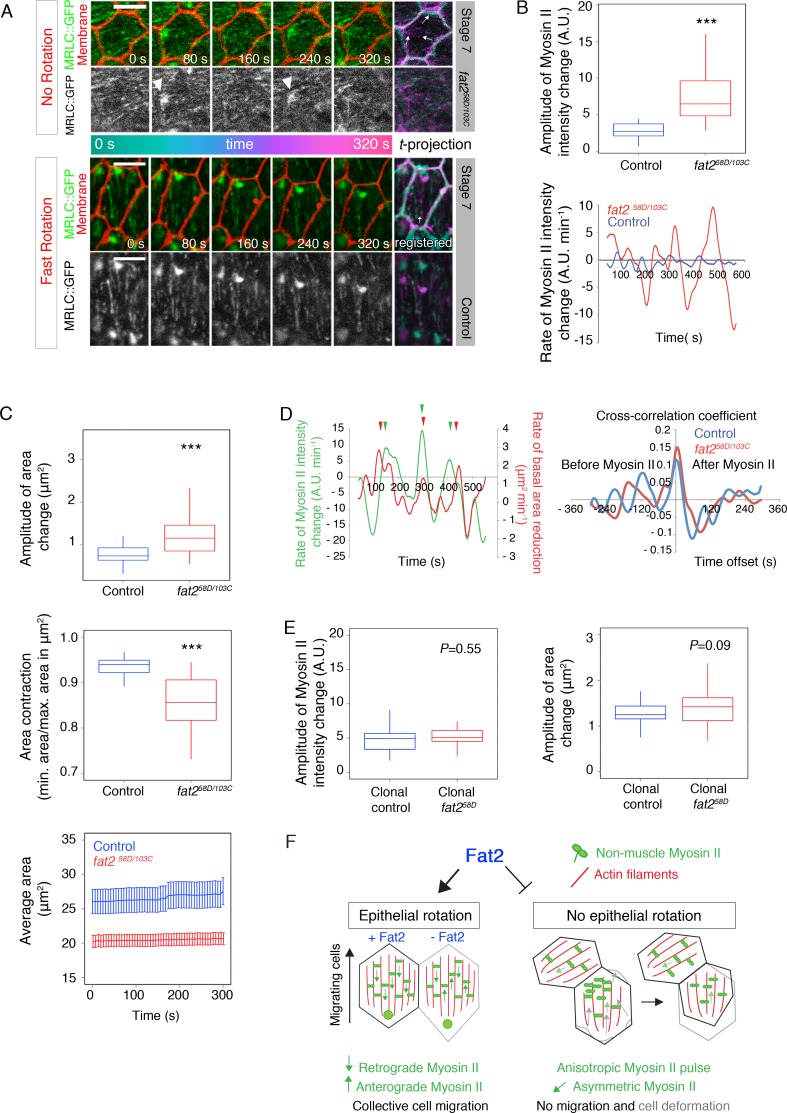
Epithelial rotation suppresses premature Myo-II anisotropic pulses and cell deformations.(A) Unequal MRLC::GFP intensity increments (Myo-II anisotropic pulse) and membrane deformations are shown in fat2 mutant follicle cells (stage 7). Arrowheads indicate an individual MRLC::GFP intensity increase (a pulse). Note that MRLC::GFP pulses were not observed in control stage 7 (data for one representative cell is shown). Scale bars = 5μm. Anterior is on the left. (B) Amplitude of Myosin-II intensity change and a single cell example of control and fat2 mutants plotting the rate of Myo-II intensity change, showing significant Myo-II pulses in fat2 mutant follicle cells. (C) Amplitude of area changes were significantly higher in fat2 mutant follicle cells than in controls. Correspondingly, area contraction [ratio of the minimal area (contraction) to the maximal area (relaxation)] was significantly weaker in fat2 mutant follicle cells. Average area of analyzed follicle cells, which was calculated for fat2 mutant follicle cells and their controls over time (300s) with S.E.M. is shown. (D) Rate of MRLC::GFP intensity change (green) and rate of the basal area reduction (red) in one representative cell temporally correlates. Peaks are marked with arrowheads of corresponding colour. Cross-correlation coefficient (average of all correlation coefficients with different time offsets) between rate of MRLC::GFP intensity and rate of follicle cell area reduction (red line) is shown. R = 0.15 with peak maxima at +6s, indicating that MRLC::GFP precedes the basal area reduction. Blue line shows the average time-dependent correlation of the control between rates of MRLC::GFP intensity change and basal area reduction. R = 0.11 with a maximum peak at 0, suggesting that MRLC::GFP and basal area reduction are almost simultaneous. (E) Comparison of amplitude of Myo-II intensity change and of area change did not show significant difference between clonal fat2 mutant cells (of small clones) and their control neighbours. (F) Fat2 suppresses unwanted Myo-II anisotropic pulses/cell deformations via facilitating epithelial rotation. Based on data from Figs 2D and 3A, Fat2 presence is also required for proper Myo-II dynamics and cell elongation control during the migratory phase. *** = P<0.001 and P values are shown. Follicle cells of stage 7 were used for both, fat2 mutant (n = 56, 7 independent egg chambers) and control (n = 28, 5 independent egg chambers) analysis (B, C, D). Follicle cells of stage 7/8 were used for clonal analysis (n = 24, 5 independent egg chambers in E).